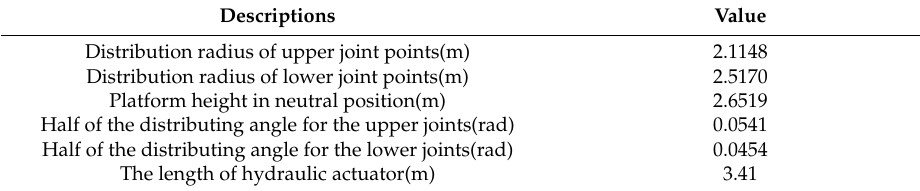
Table 1. Configuration parameters of the Simulink ® model. Table 2. Nominal dynamic parameters of the Simulink ®